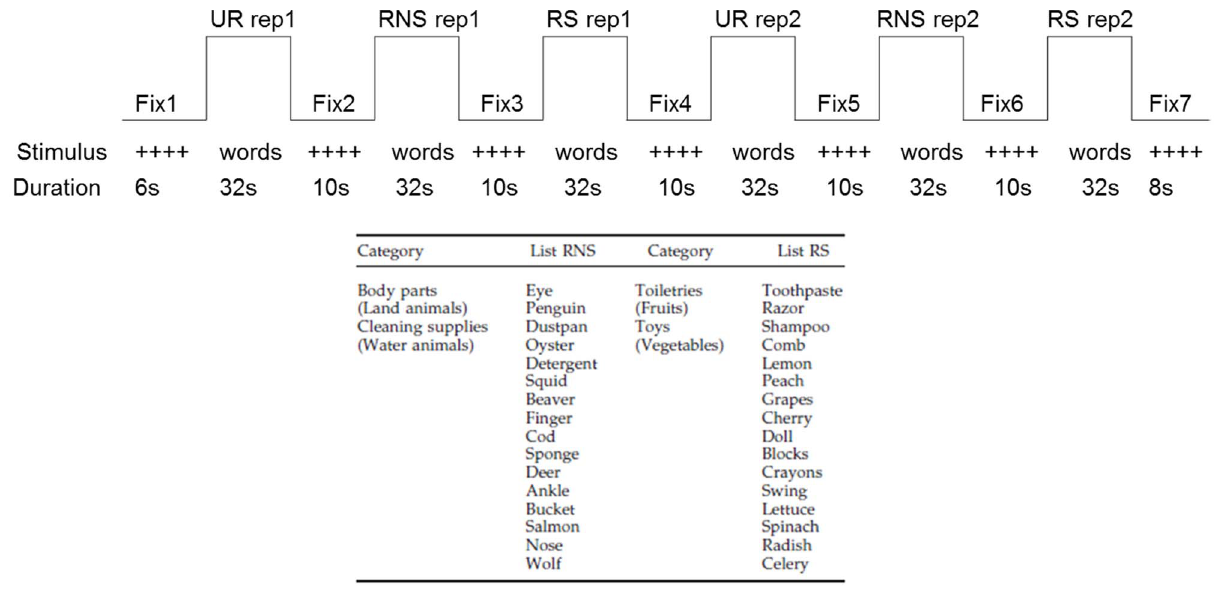
Figure 2. Experimental paradigm. Experimental conditions: fixation baseline ( + ); unrelated words (UR); related-structured words (RS); related- non-structured words (RNS). There were three runs, each run with 48 words and total number of words in the first or second fMRI session=144 words.